Question: Give a one-sentence summary of this figure.
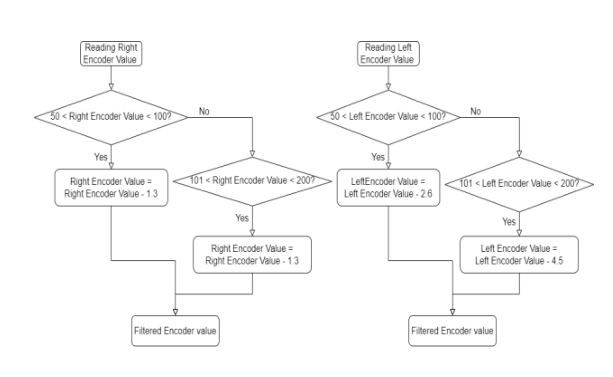
Answer: The calibration process for minimizing the encoder reading error.